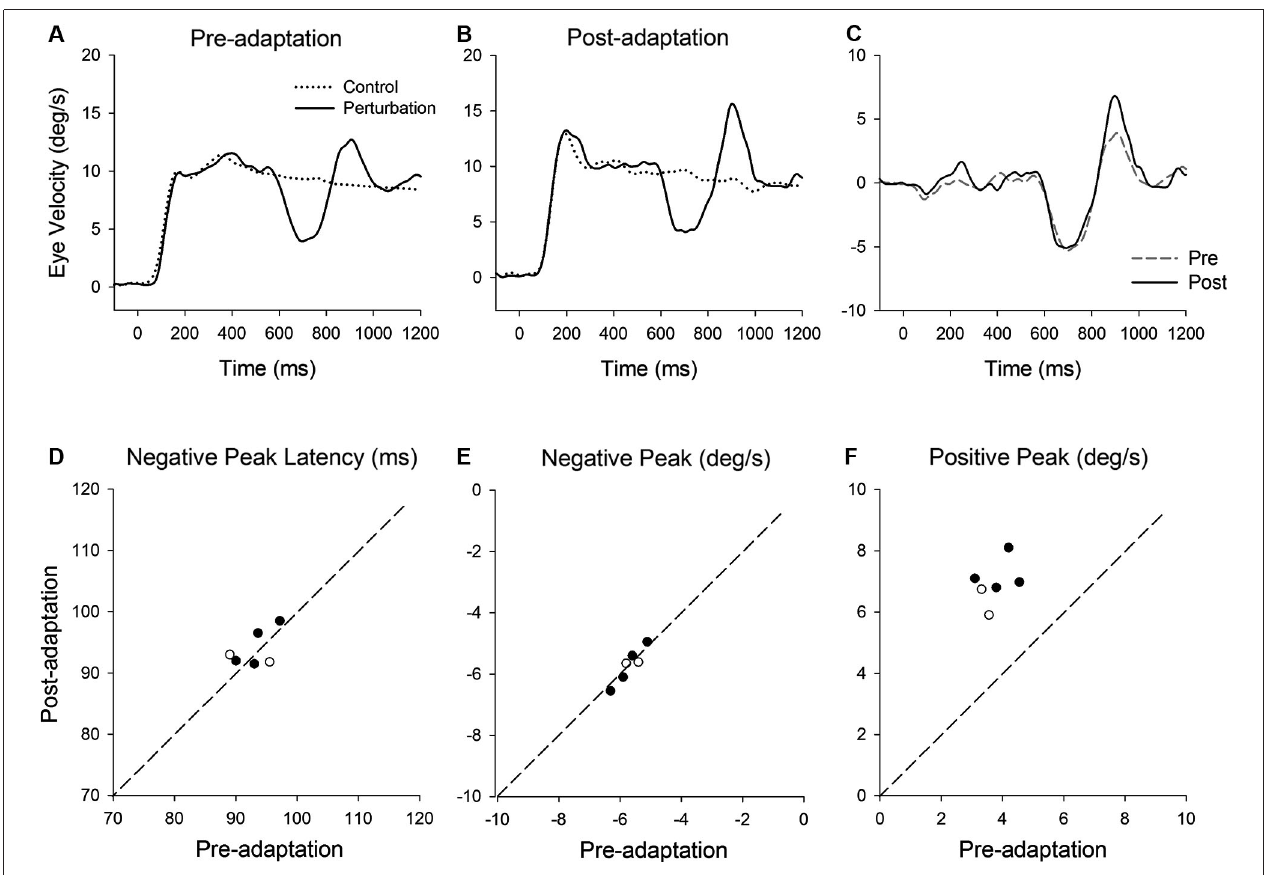
(solid line). (D) Mean values of perturbation latency, (E) negative peak velocity and (F) positive peak velocity are shown pre- and post-adaptation. Open and filled symbols indicate monkey-P and B,